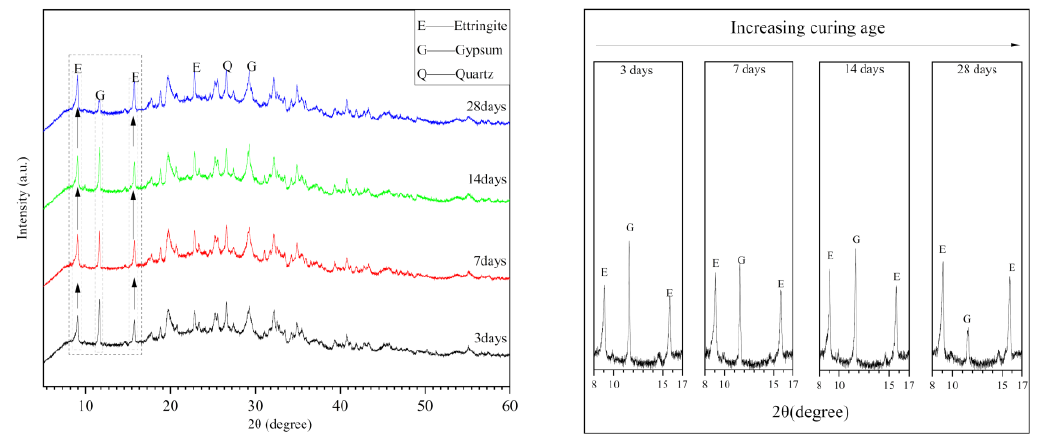
Figure 7. XRD patterns of FCG paste for 5% FGD at different curing ages.